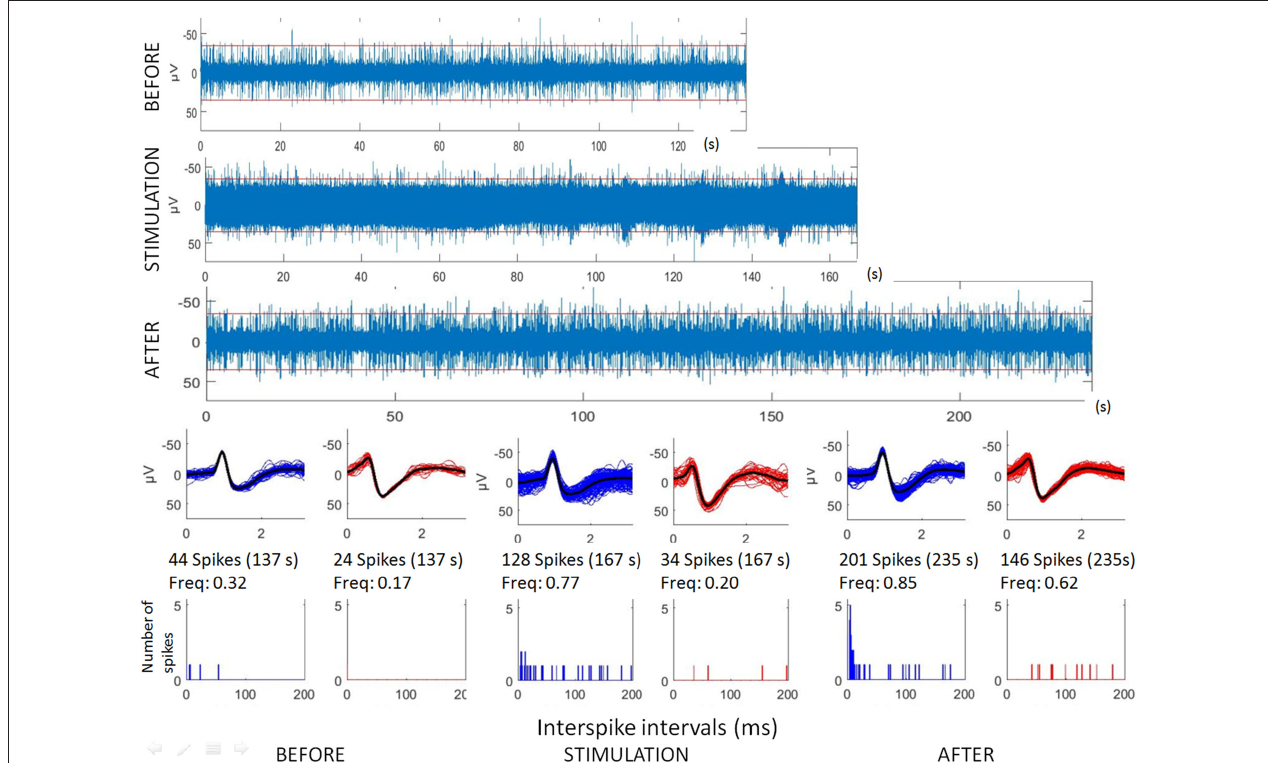
FIGURE 1 | Analyses of hippocampal microstimulation (patient H1, 1 Hz). Top: raw microelectrode recordings (before, during and after stimulation; [150–3000Hz]). Middle: spike waveforms obtained with clustering of microelectrode recordings (number of spikes, duration of the recordings, frequencies of spike occurrences—Freq). Bottom: interspike interval histograms (ordinate number of times that the delay between two consecutive spikes is within the category given in abscissa, with categories of 1 ms. Note that all spikes were not found with delay between two consecutive spikes lower than 200 ms.